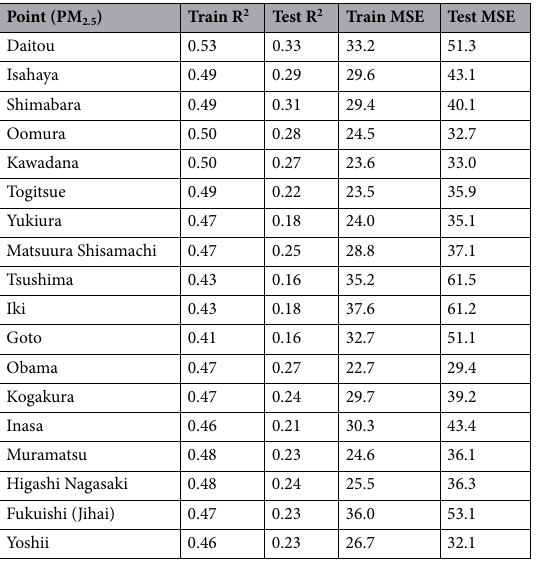
Figure 5. RF feature selection for PM2.5 and NO 2 of different monitoring stations in Nagasaki Prefecture, Japan. Point (PM 2.5